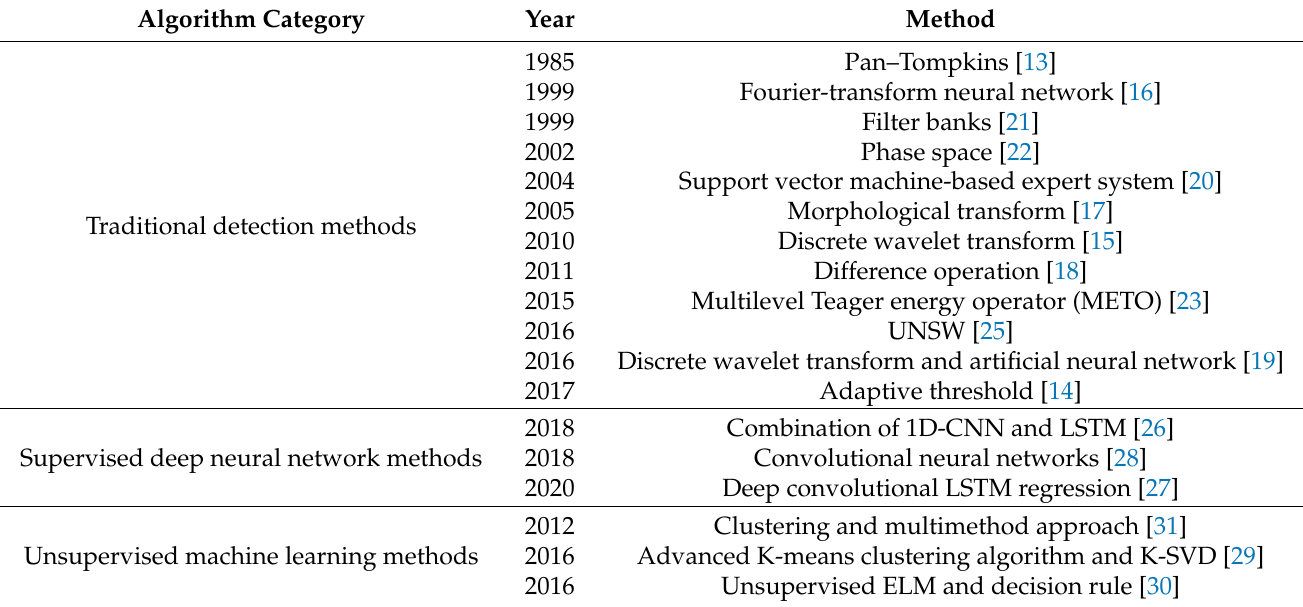
Table 1. The related works of R wave